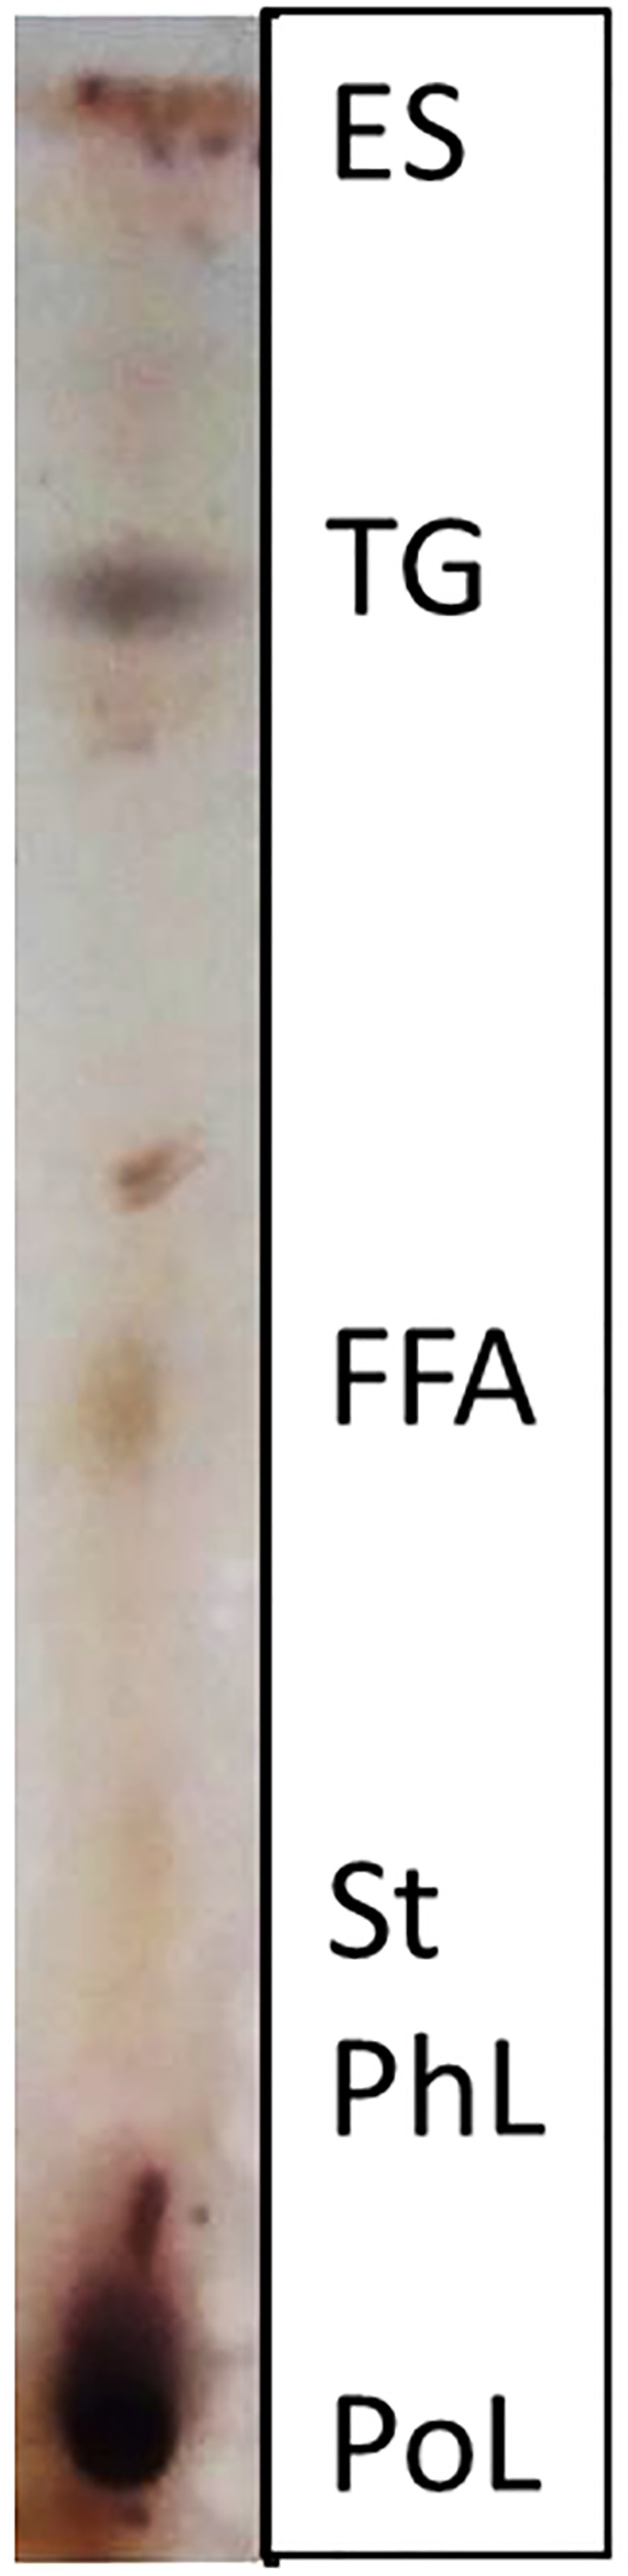
Thin layer chromatograply (TLC) analysis of lipid fraction. PoL, polar lipids; PhL, phospholipids; St, sterols; FFA, free fatty acids; TG, triglycerides; ES, esters.